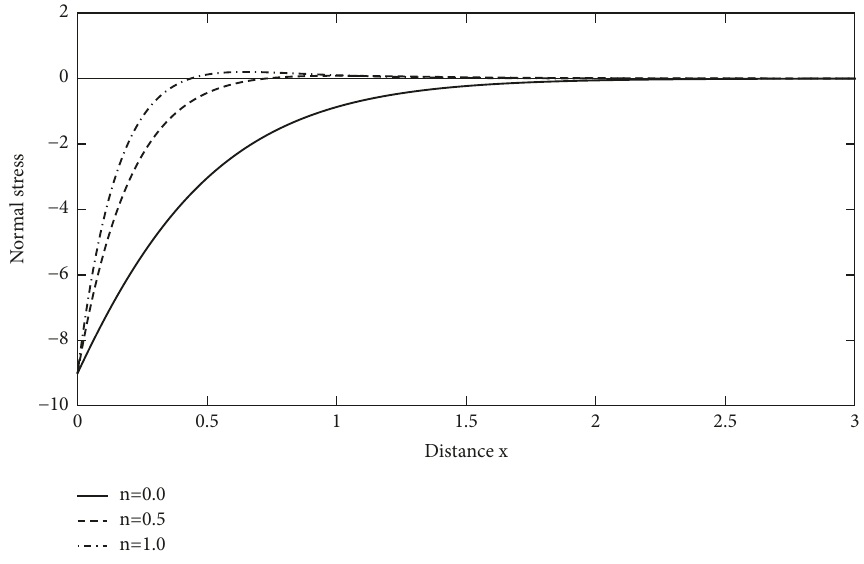
Figure 7: Effect of nonhomogeneity parameter on normal stress